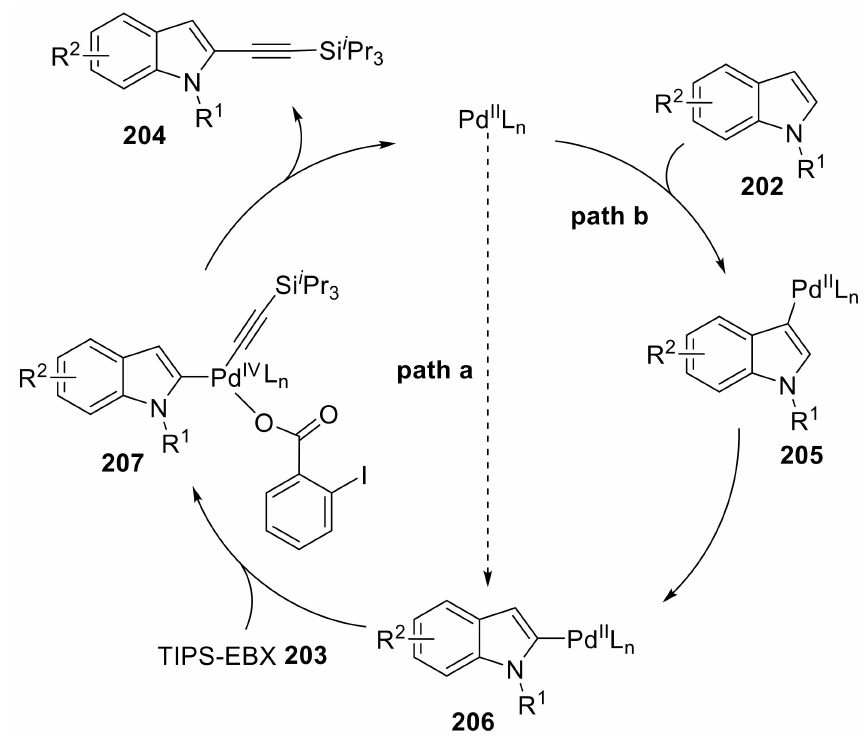
Scheme 64. The proposed catalytic cycle for Pd-catalyzed C2-alkynylation of 202 to afford alkynylated products 204